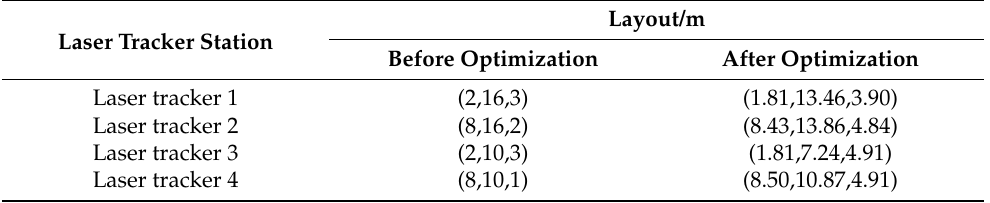
Table 1. Layout of laser trackers before and after the layout